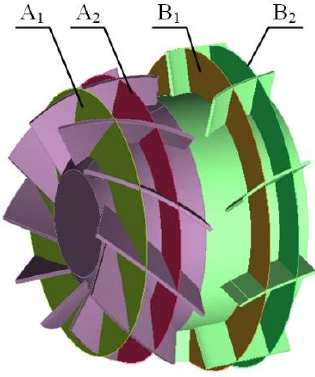
Figure 16. Cross-section of blade in different flow